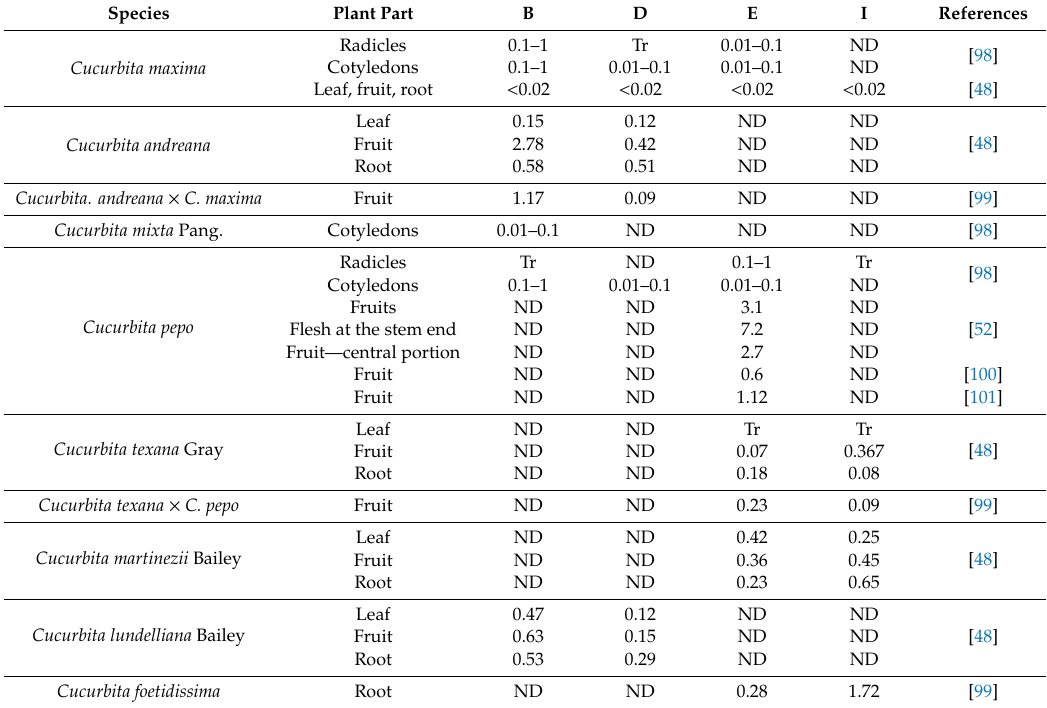
Species Plant Part Species Plant part B